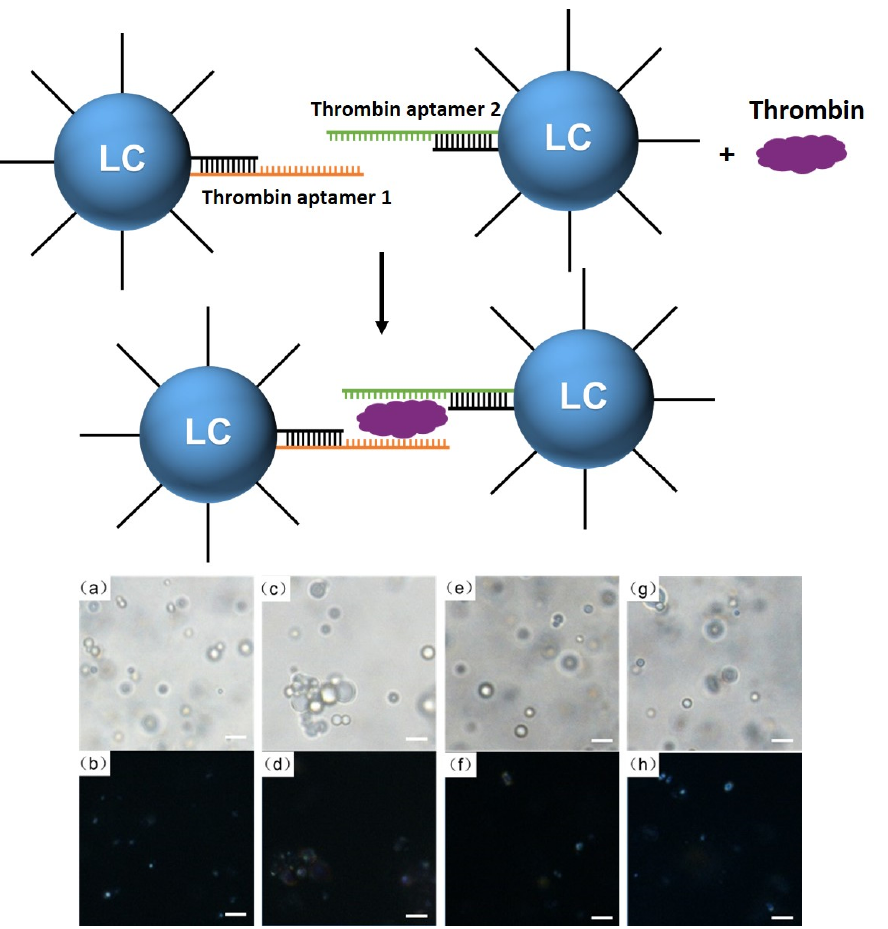
Figure 5. Schematic representation of the responsiveness of LC droplets to thrombin. Optical images of ( a , b ) the DNA ‐ modified LC droplets hybridized with thrombin aptamer 1 and aptamer 2, respec ‐ tively, and in the presence of ( c , d ) 1 μ M, ( e , f ) 5 μ M, ( g , h ) 10 μ M thrombin in bright field ( a , c , e , g ) and polarized field ( b , d , f , h ). Scale bar is 10 μ m.